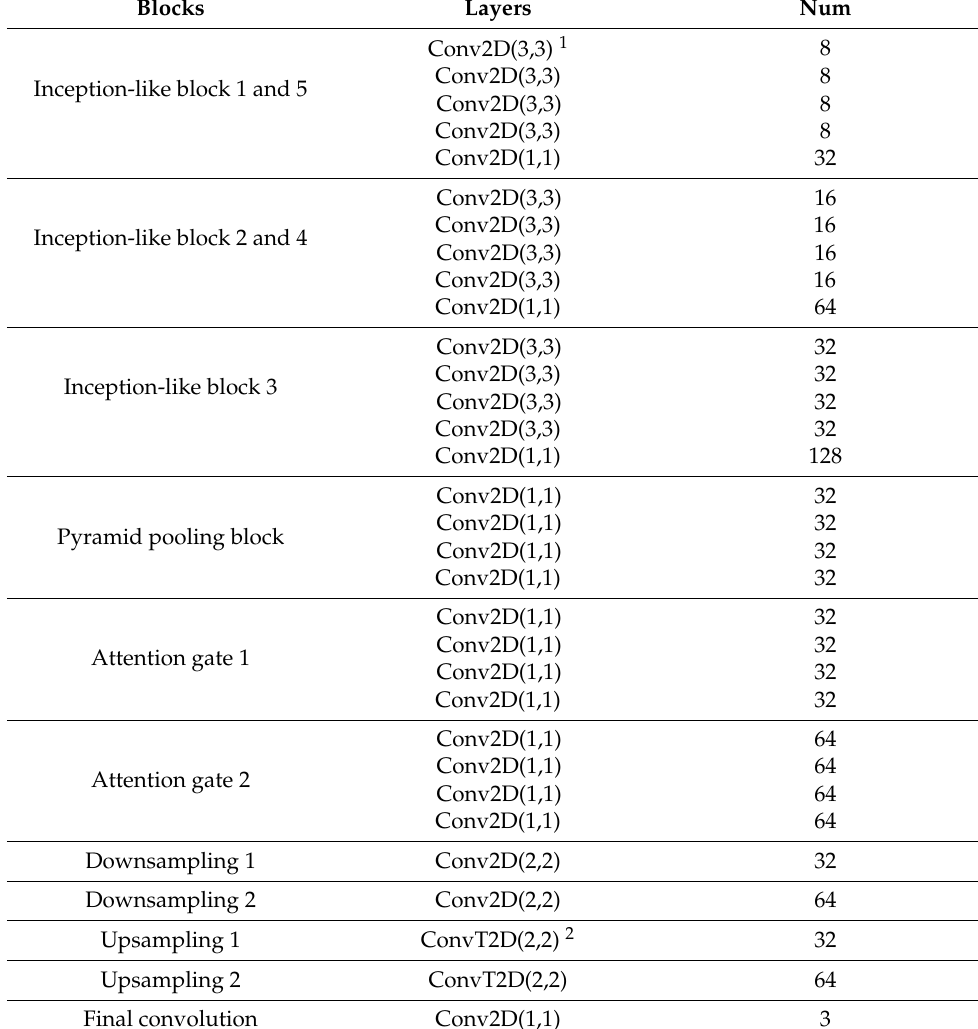
Table 1. Parameters of proposed